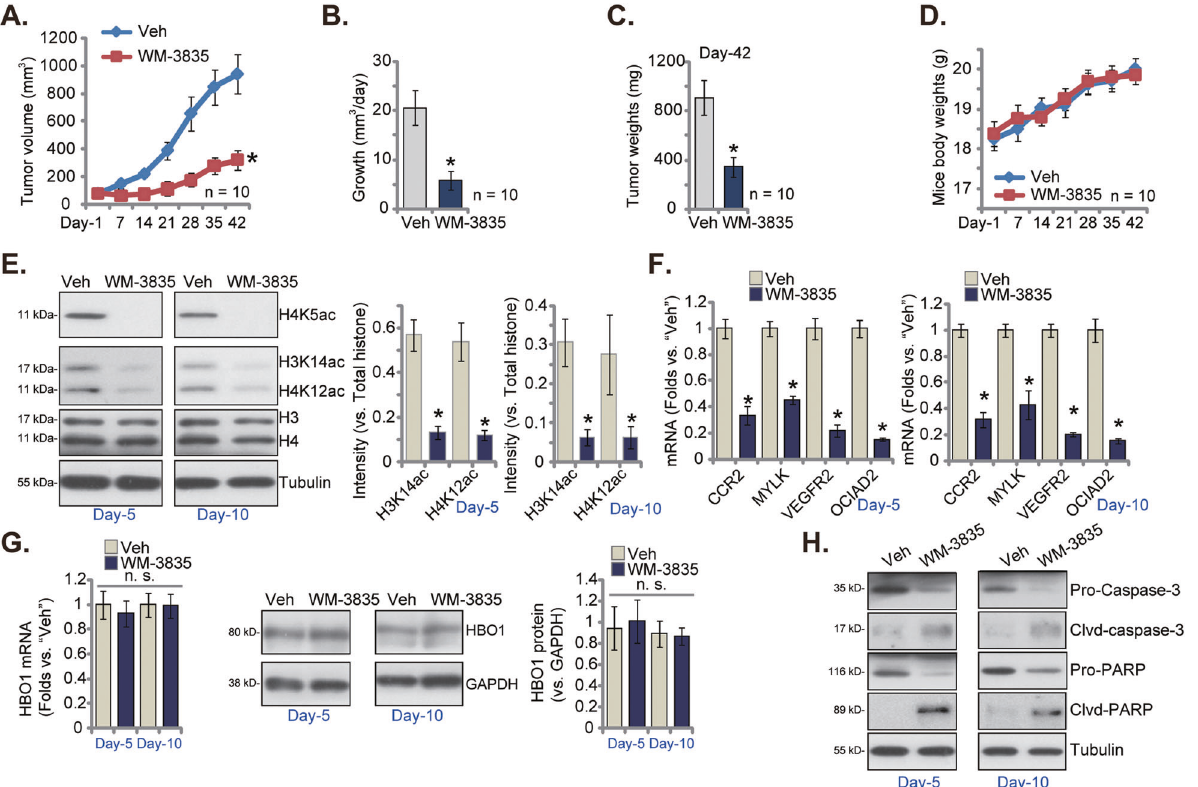
Fig. 7 WM-3835 injection hinders pPC-1 xenograft growth in nude mice. The pPC-1 xenograft-bearing nude mice were intraperitoneally ( i.p .) injected with WM-3835 (at 5 mg/kg body weight, daily for 14 days) or the vehicle control ( “ Veh ” ), tumor volumes ( A ) and mice body weights ( D ) were recorded every seven days ( “ Day-1 ” to “ Day-42 ” ), daily tumor growth (in mm 3 per day, B ) and tumor weights (at Day-42, C ) were measured as well. Expression of listed genes and proteins in the listed pPC-1 xenograft tissue lysates was tested ( E – H ). Data were expressed as the mean ± standard deviation (SD). * P < 0.05 versus “ Veh ” group. “ n. s. ” stands for non-statistical difference ( P > 0.05).